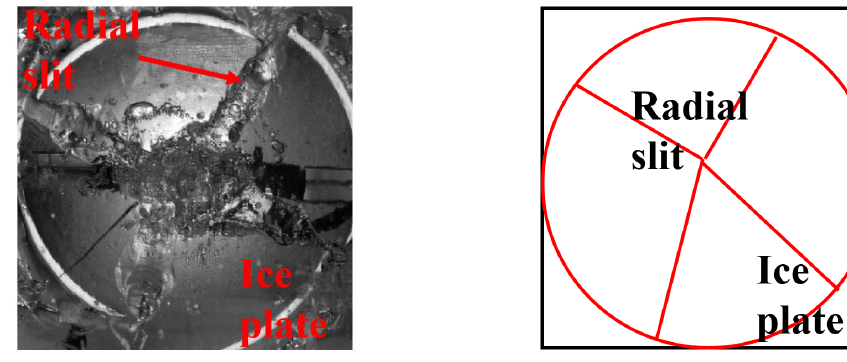
Figure 9. Radial slits pattern when H = 0.53, T = 0.27.